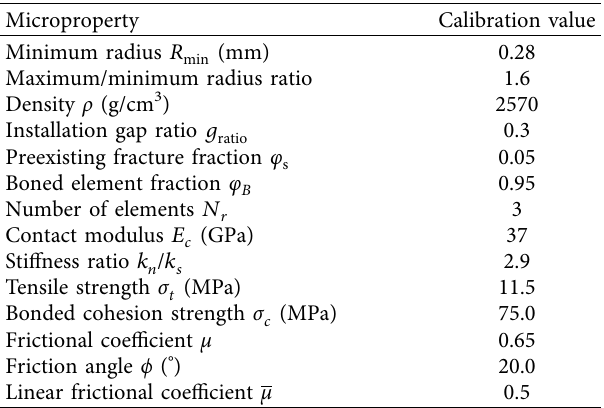
Figure 8: Brazilian tensile strength. (a) Stress-strain curves of the BTS tests. (b) Failure mode (right: laboratory test and left: numerical test). Table 2: Microproperty calibration results of the FJM.